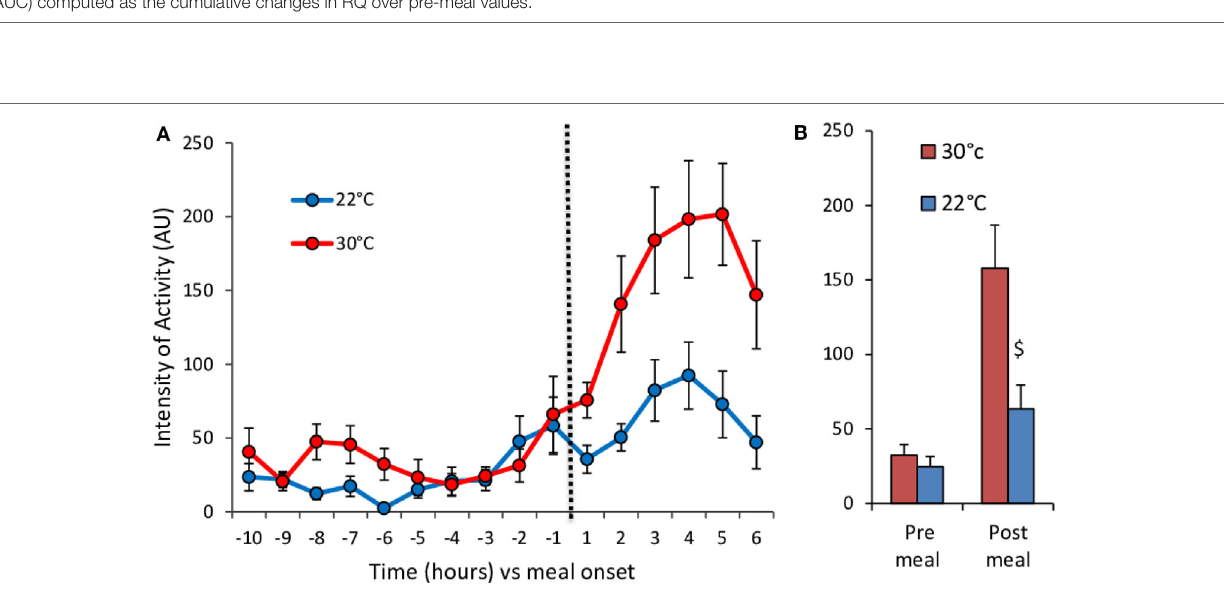
FigUre 5 | hourly changes in the level of spontaneous activity (a) and mean activity values (B) before (pre-meal) and after (post-meal) delivery of the test-meal at 30°c ( n = 11) and 22°c ( n = 10) . (a) Time effect, P < 10 − 15 ; temperature effect, P < 10 − 9 ; time × temperature effect, P < 10 − 4 . (B) $, P < 0.01.